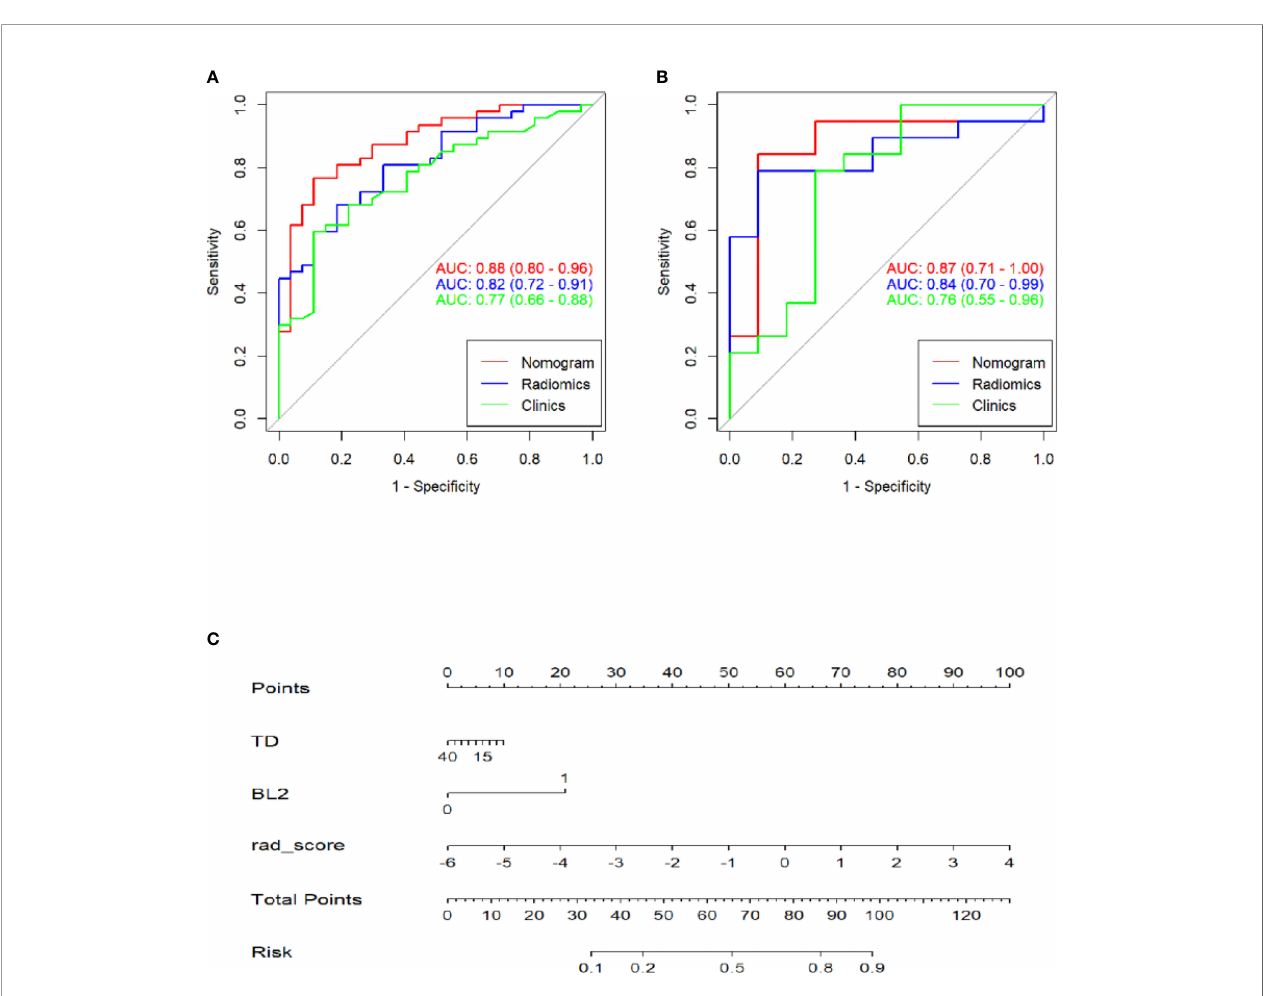
FIGURE 4 | Receiver operating characteristic (ROC) curves of the clinics, radiomics and combinations of computed tomography (CT)-based radiomics signatures used to discriminate between complete and incomplete ablation of pulmonary malignancies in the training and validation cohorts (A, B) . Radiomics nomogram (C) used to discriminate complete and incomplete ablation of pulmonary malignancies. The nomogram was based on the training cohort; the rad-scores are shown. Initially, vertical lines were drawn at the rad-score values to determine the values of the points. The fi nal point value was the sum of those of the two points. Finally, a vertical line was drawn at the total point value to determine the probability of complete pulmonary malignancy